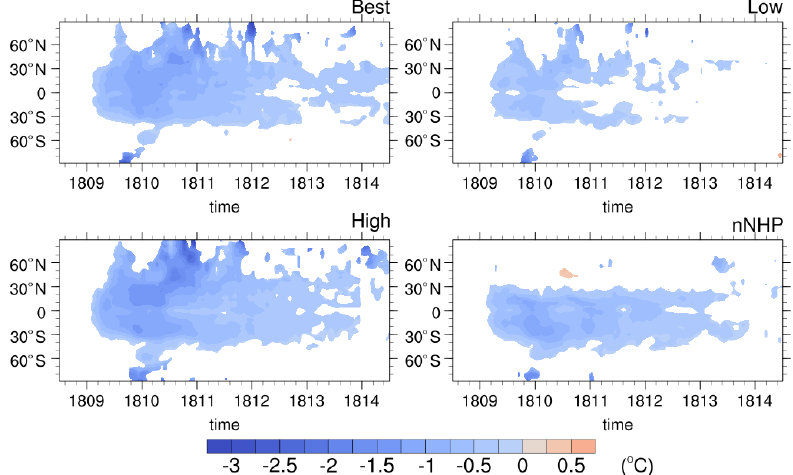
Figure 4. Simulated ensemble-mean zonal-mean near-surface air temperature anomalies ( ◦ C) for the four MPI-ESM experiments. Only anomalies exceeding 1 standard deviation of the control run are shown. Anomalies are calculated with respect to the pre-eruption (1800– 1808)